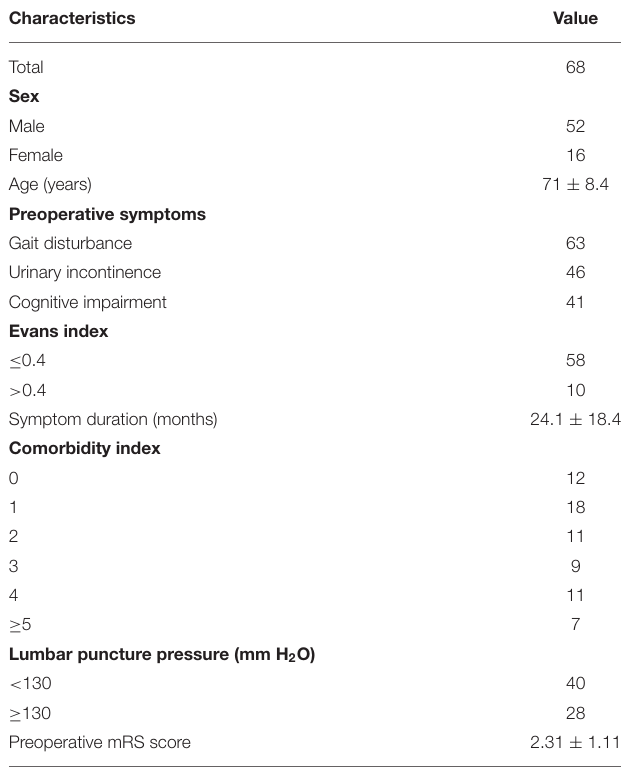
TABLE 2 | Baseline characteristics of 68 patients with idiopathic normal-pressure hydrocephalus. Characteristics